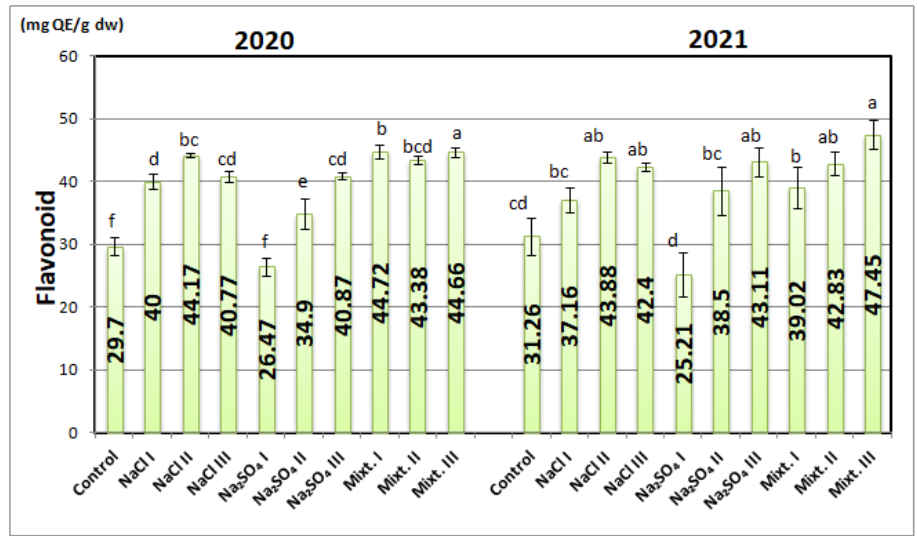
Figure 8. Flavonoid content of N. cataria L. studied variants with significant differences at 0.001 level indicated with letters.